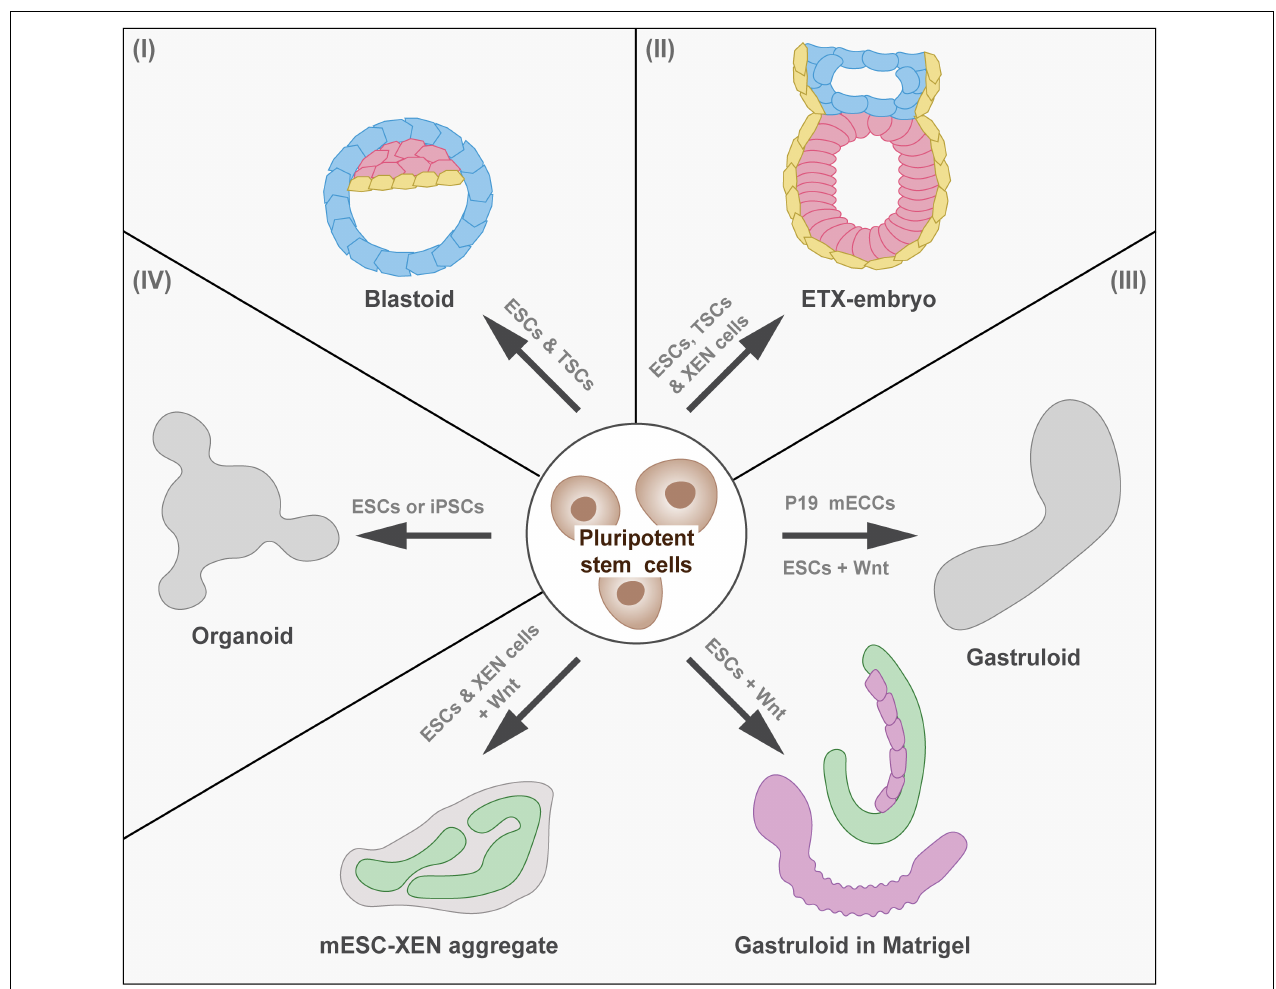
FIGURE 1 | In vitro models of mammalian development. Overview of model systems of pre-implantation and post-implantation development (I) Pre-implantation development: Blastoids model the blastocyst stage (mouse E3.5, human E5.0). (II) Peri-implantation and post-implantation development: ETX embryos model implantation and early stages of gastrulation (mouse E6.5, human E17.0). (III) Post-implantation development: Gastruloids show axial elongation and form cell types of the three germ layers (mouse E8, human E20.0). When embedded in Matrigel, gastruloids form segments and tubular structures resembling the posterior end of the mouse embryo. Adding extraembryonic endoderm (XEN) cells to ESCs during the gastruloid protocol results in the formation of neural tube-like structures, which recapitulate neural induction during development. (IV) Organogenesis (mouse E8.0, human E20.0): Developmental trajectories can be followed in vitro to generate organoid models of for instance the intestine. ESCs, embryonic stem cells; TSCs, trophoblast stem cells; EPS, extended pluripotent stem cells; ETX, embryonic stem cells, trophoblast stem cells, and extraembryonic endoderm cells; cAMP, cyclic adenosine monophosphate; ECCs, embryo carcinoma cells; iPSCs, induced pluripotent stem